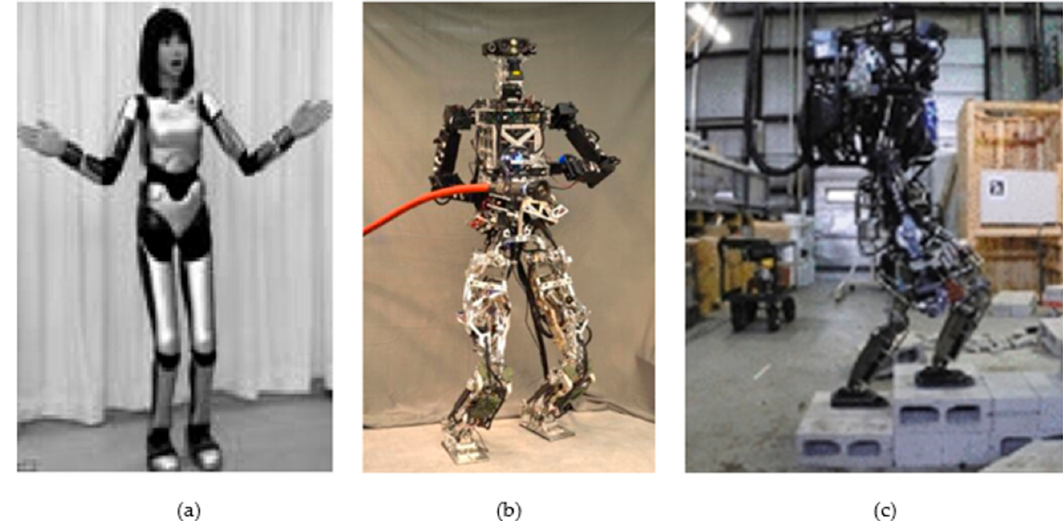
Figure 2. Popular bipedal robots at current stage. ( a ) HRP-4C used for entertainment; ( b ) SAFFiR used for firefighting; ( c ) Atlas walking on an uneven ground. (( a ) was reproduced with permission from [36]; ( b ) was reproduced with permission from [48], Copyright Elsevier, 2015; ( c ) was reproduced with permission from [49], Copyright Springer, 2016.)